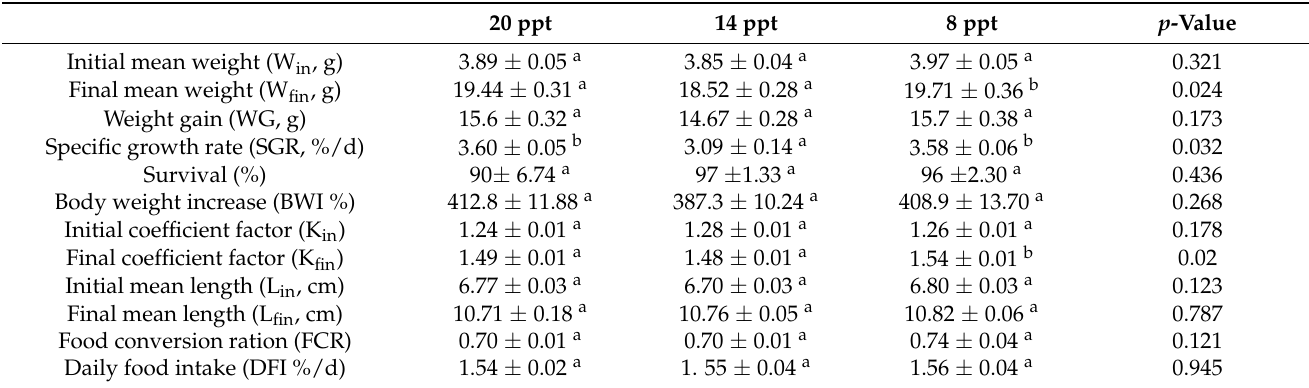
Table 2. Gilthead sea bream growth performance of the trials during the 45 days of cultivation in brackish aquaponics systems.